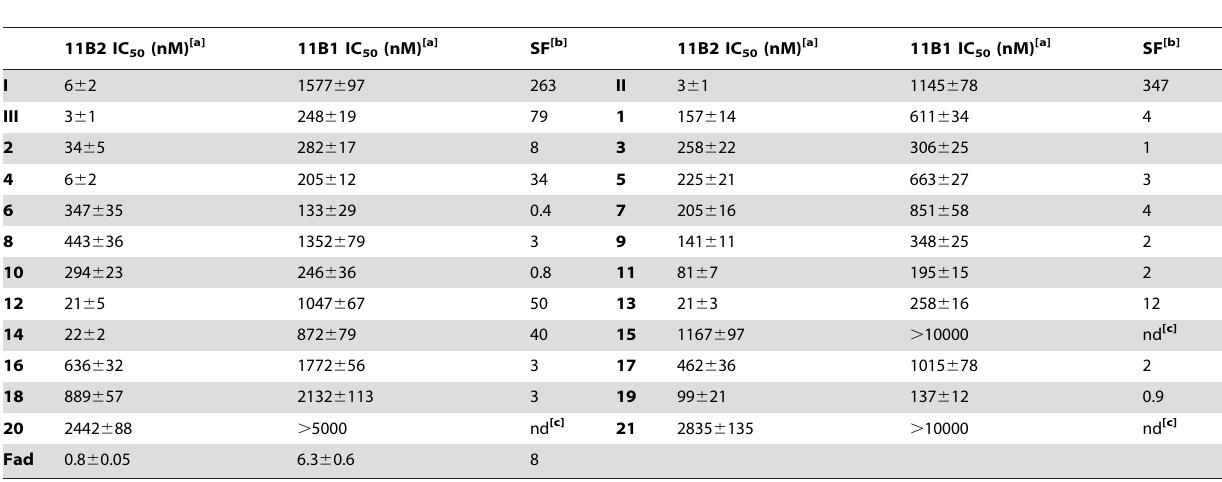
Table 1. Inhibition of human CYP11B1 and CYP11B2 by references I – III and compounds 1 – 21 .